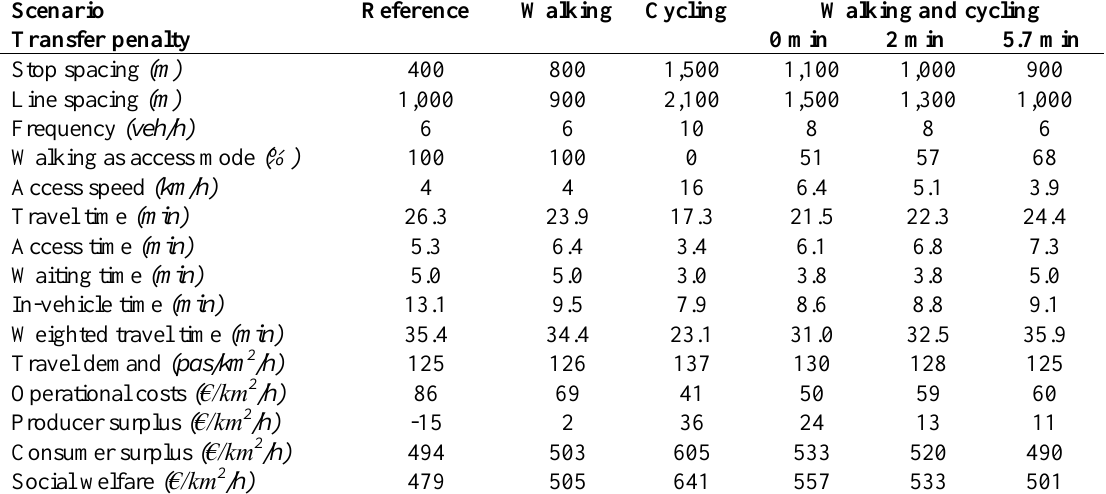
Table 2. Optimal network parameters and performance characteristics for different access modes for an average peak